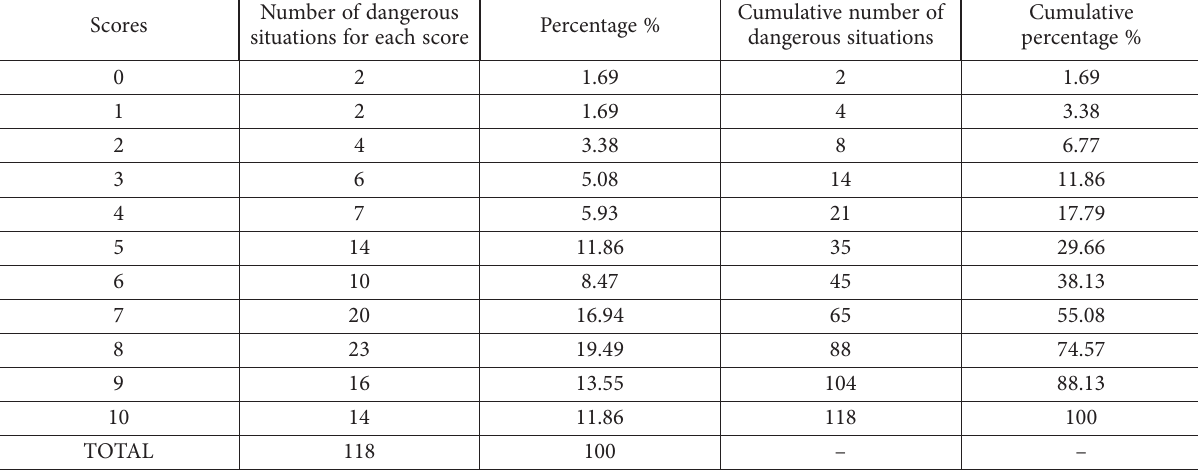
Table 1. Scores given by the members of Sample 1 to the dangerous situations that they have encountered during their aeronautical